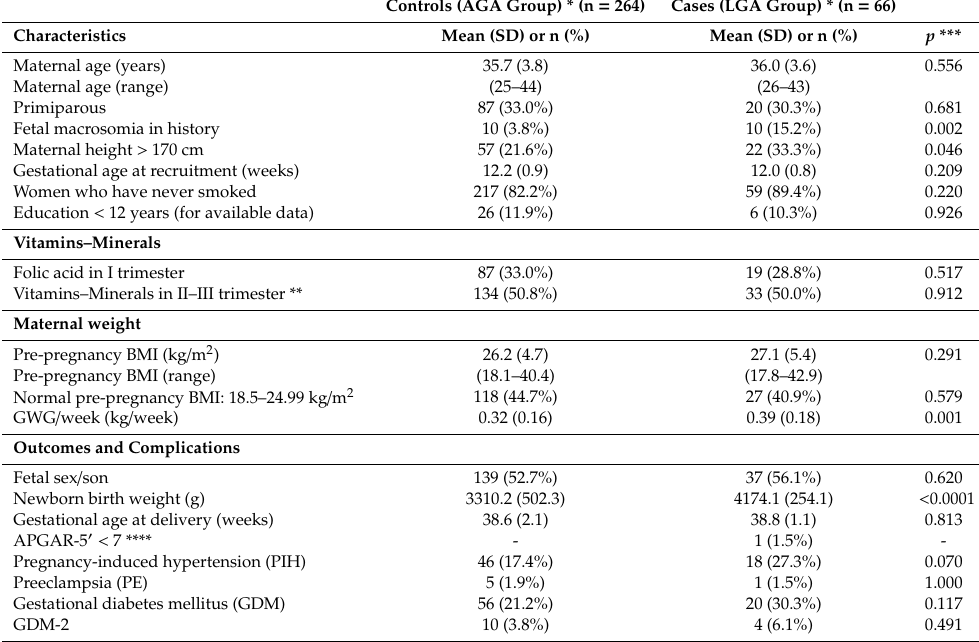
Table 1. The characteristics of mothers in the appropriate-for-gestational age birth weight (AGA) and large-for-gestational age birth weight (LGA) group.